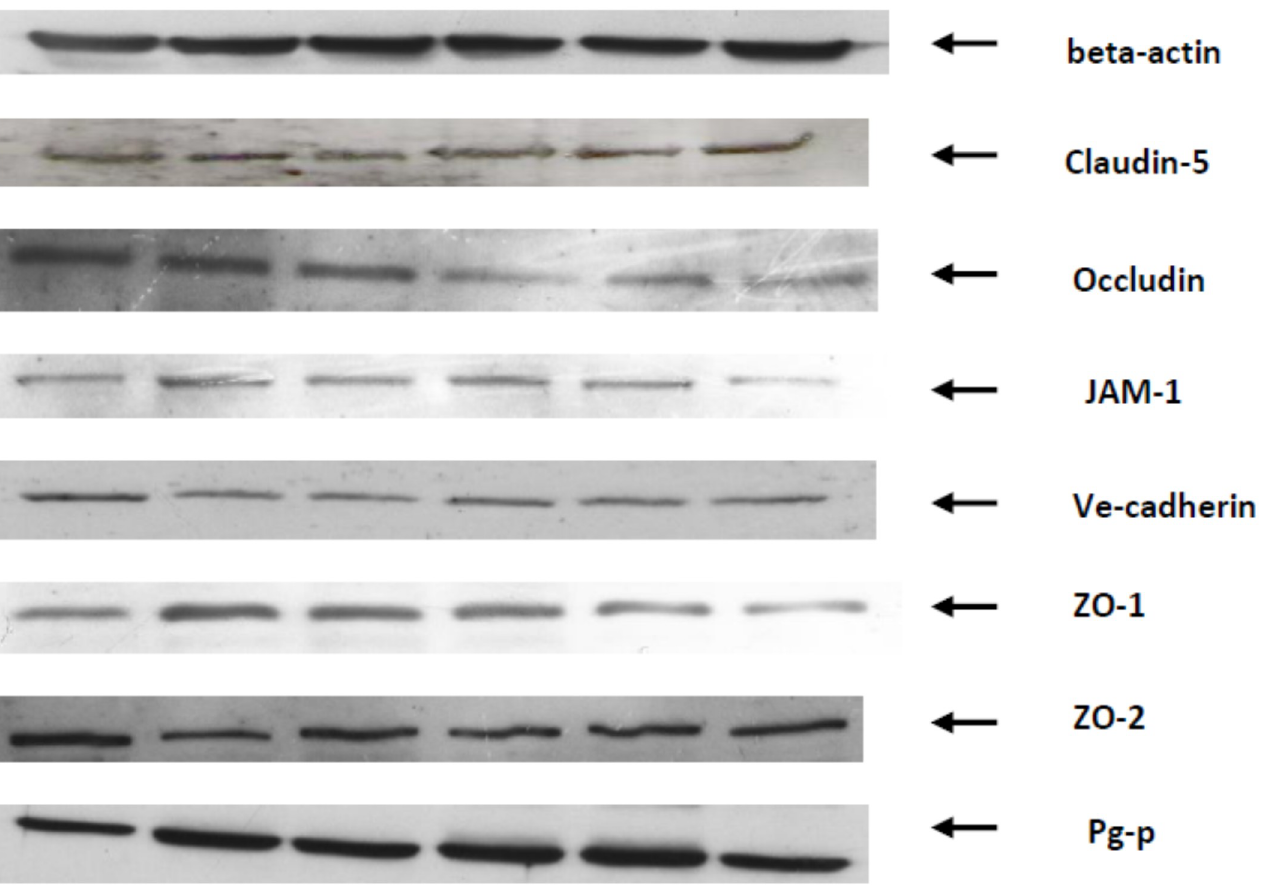
Fig 1. Representative western blot images of the blood-spinal cord barrier proteins of rats after endurance training and/or treatment with two doses of testosterone.